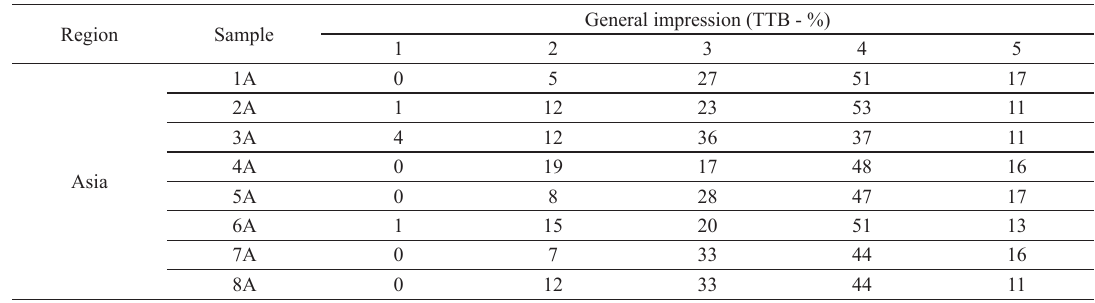
Table 4. Sensorial analysis of attribute ‘general impression’ for products in Asia. Region Sample